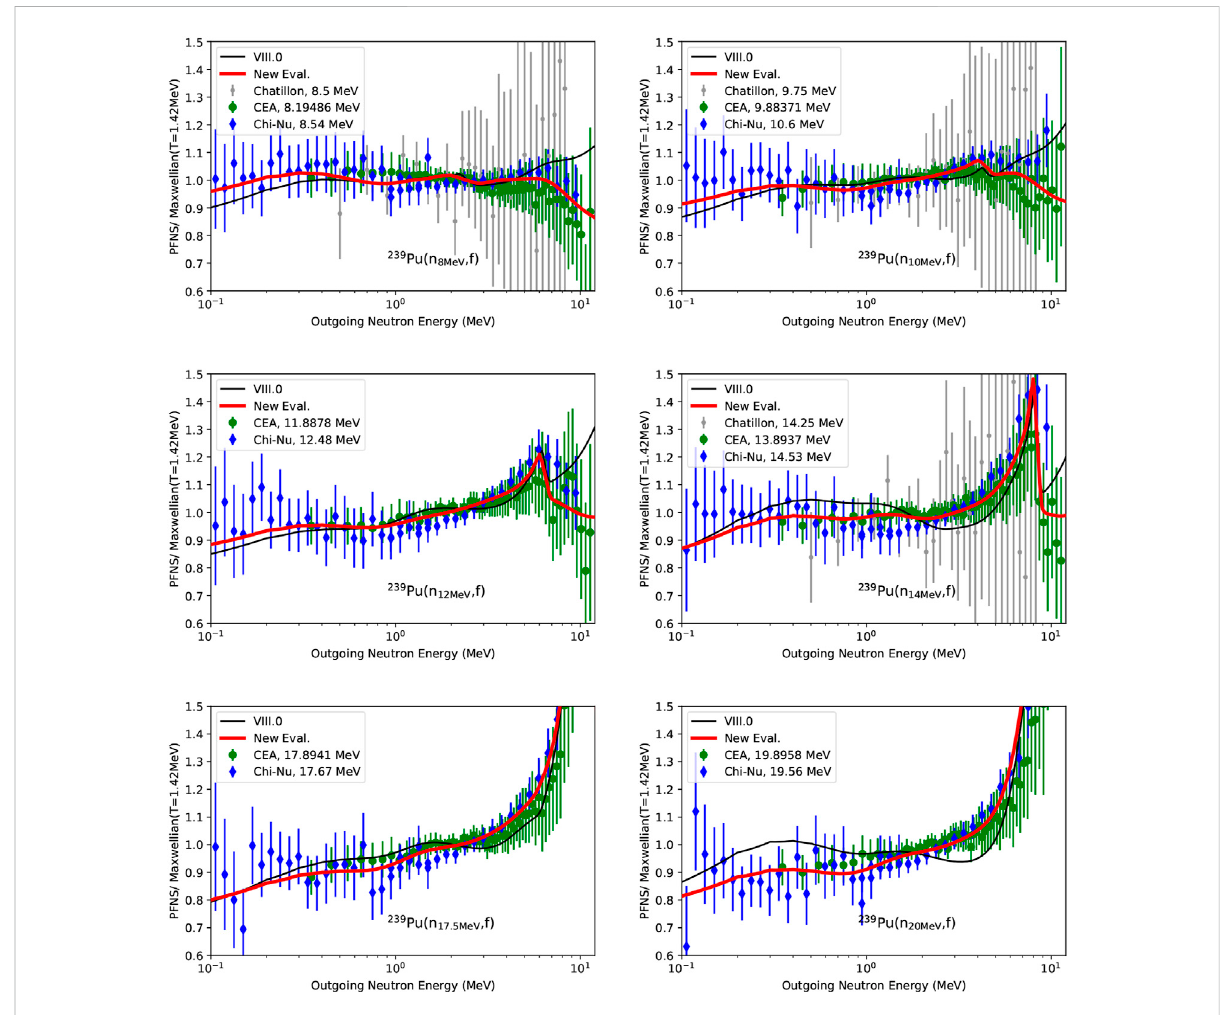
FIGURE 2 Same as Figure 1 for incident neutron energies from 8 to 20